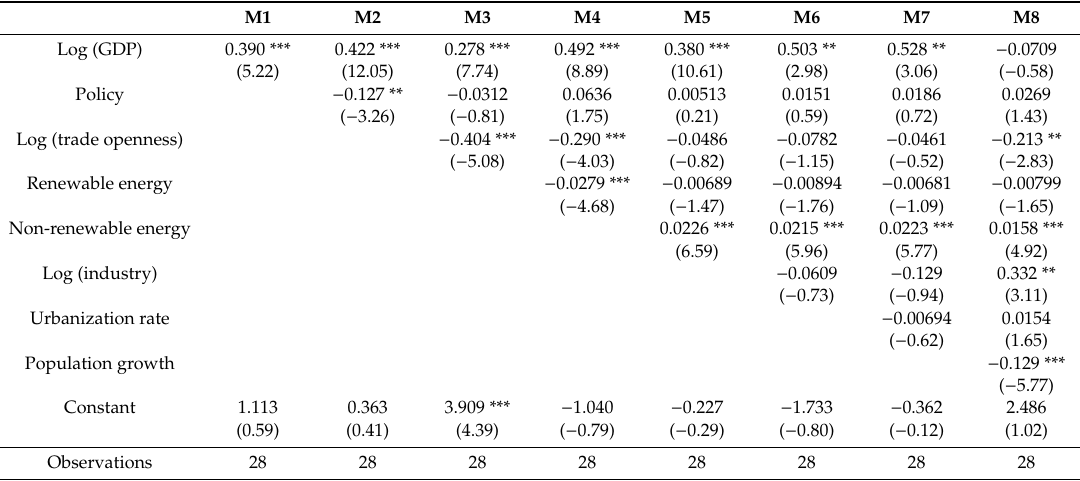
Table 7. Relationship between CO 2 emissions and GDP, with control variables in the upper-middle-income countries